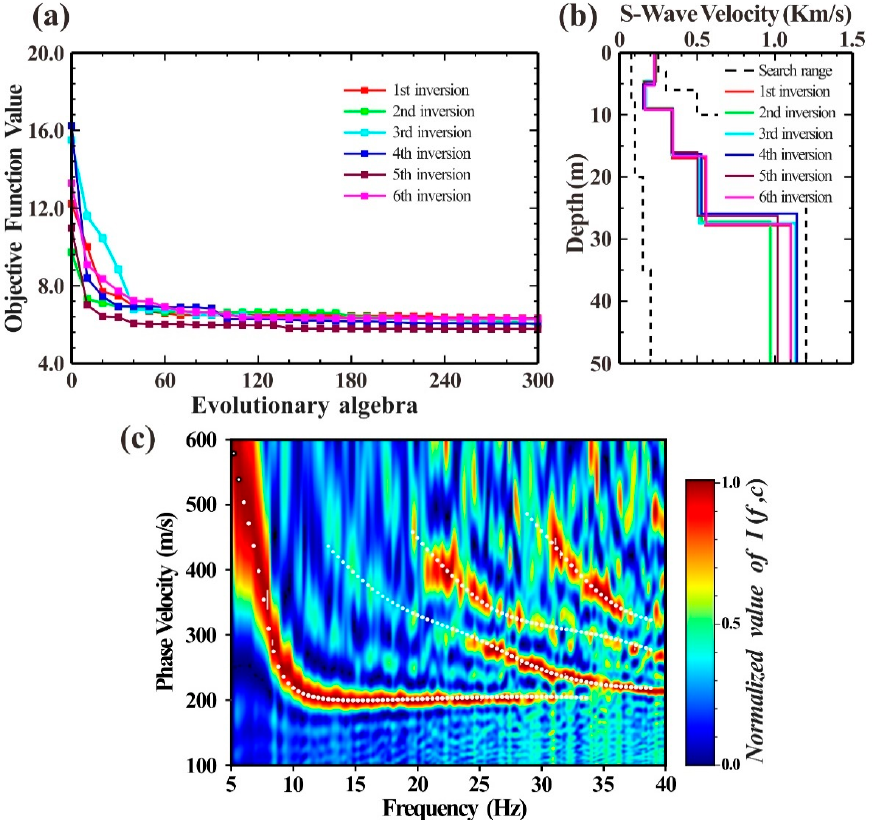
Figure 12. Joint inversion results of fundamental and higher-order dispersion curves. ( a ) Curve of objective function value; ( b ) inverse S-wave velocity structure; ( c ) comparison between the theoretical dispersion curve corresponding to the first inversion result and the measured dispersion diagram. The white dotted line is the fundamental and higher-order dispersion curve of the theoretical calculation.